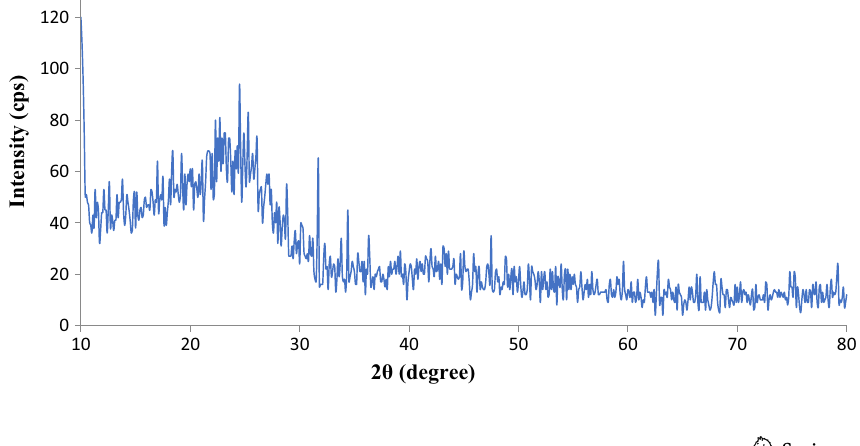
Fig. 1 XRD spectrum for AC– ZnO